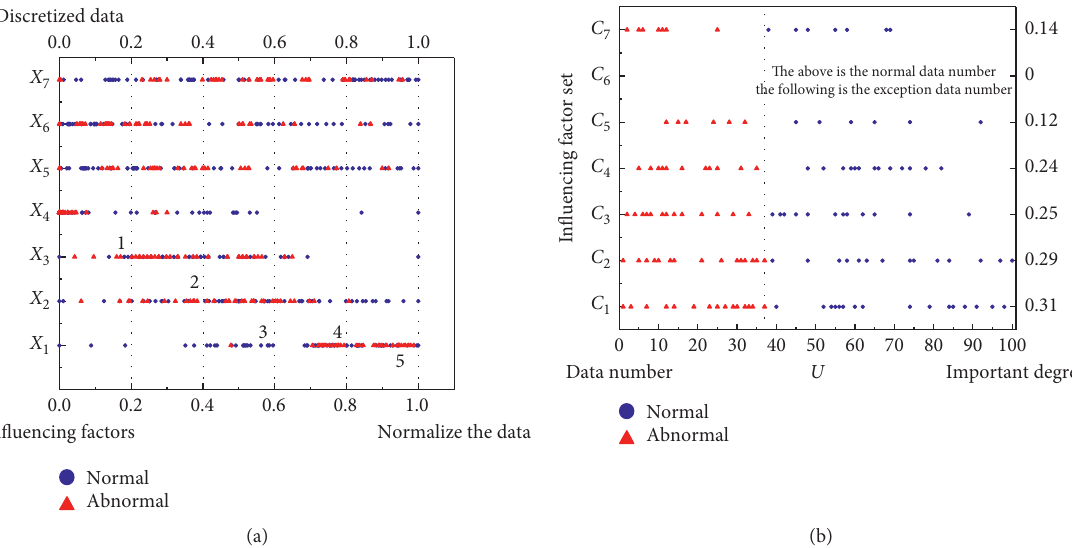
Figure 7: Rough set theory decision making and attribute reduction classification. (a) Decision sequence of influencing factors of the seepage pressure water level. (b) Reduction classification results of influencing factors of the seepage pressure water level.